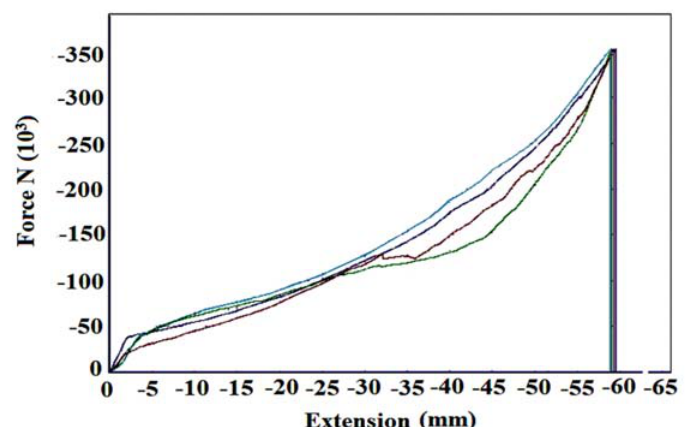
Figure 12: Comparison of displacement and force diagrams of different specimens.